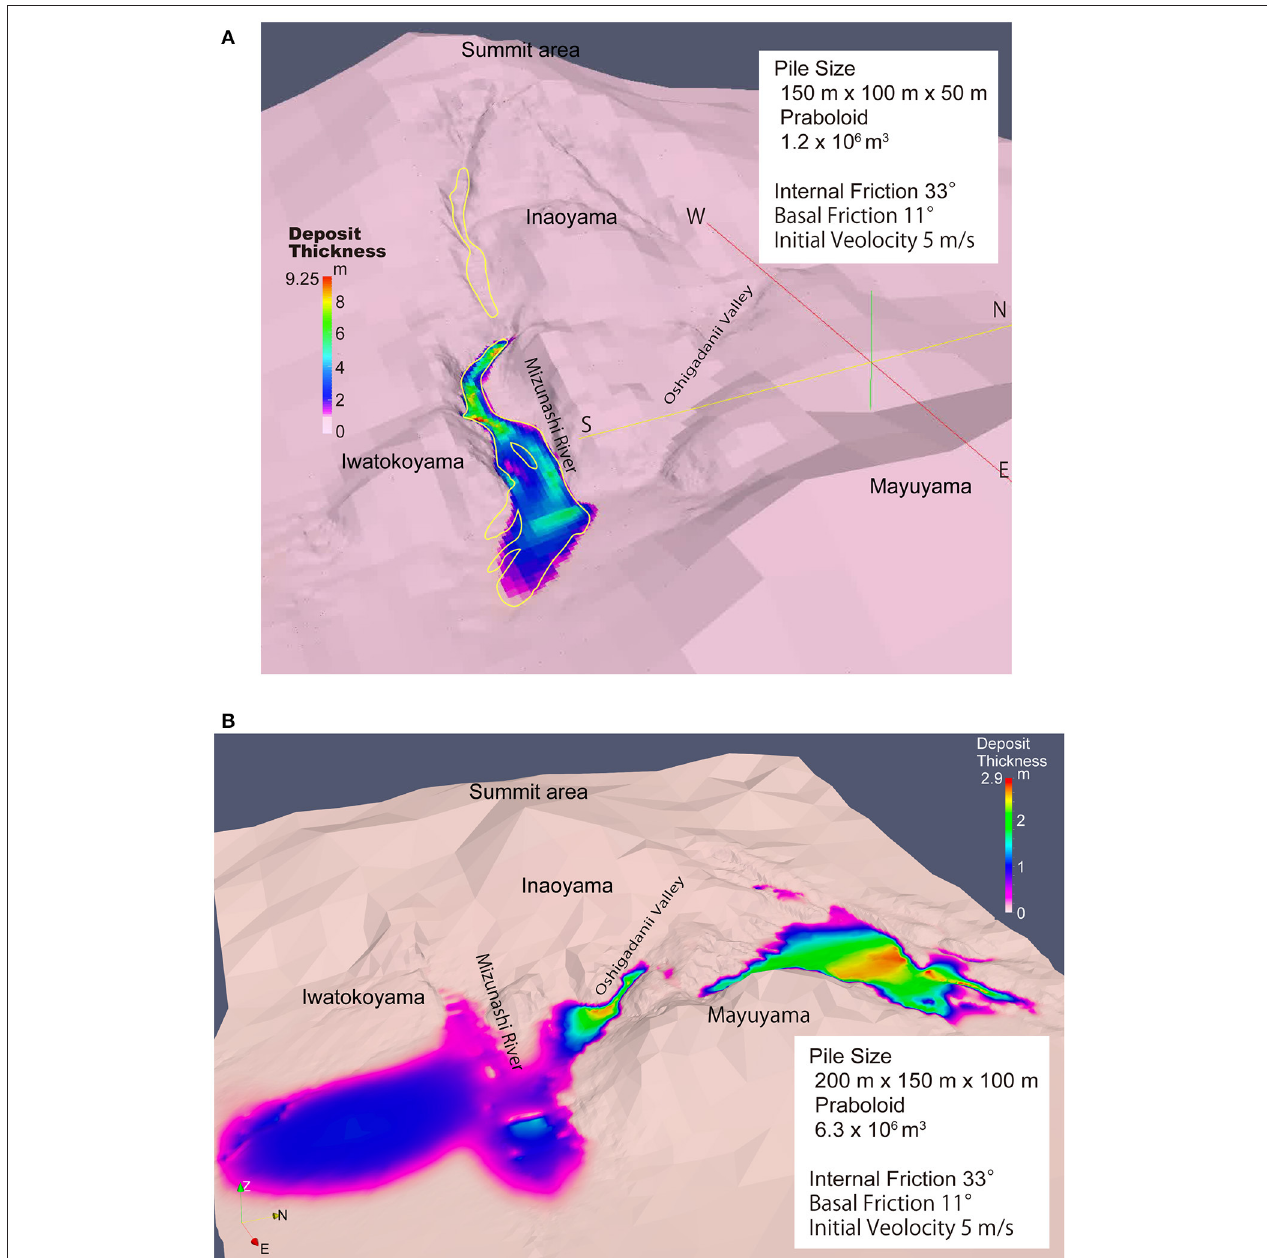
FIGURE 8 | Titan2D simulation results of the Unzen block-and-ash flows. (A) The result of the June 3, 1991 event. The yellow lines indicate the observed distribution of the deposit. The collapsed pile size was 150 × 100 × 50m (1.2 × 10 6 m 3 ). The internal and basal frictions were 33 ◦ and 11 ◦ , respectively. A pre-eruption DEM was used for the simulation. Please note that the DEM is only shown in detail at 10m resolution in and around the deposit (to minimize the simulation time). (B) A large-scale simulation result of Unzen block-and-ash flow. The collapsed pile size was 200 × 150 × 100m (6.3 × 10 6 m 3 ). The internal and basal frictions were 33 ◦ and 11 ◦ , respectively. The present DEM at 10m resolution was used. The block-and-ash flow deposit distributes a wider area (not only confined in the Mizunashi River, but also in the Oshigadani Valley, NE and SE flank regions). Parallel lineaments in the deposits in the Mizunashi River are caused by the presence of artificial dikes.